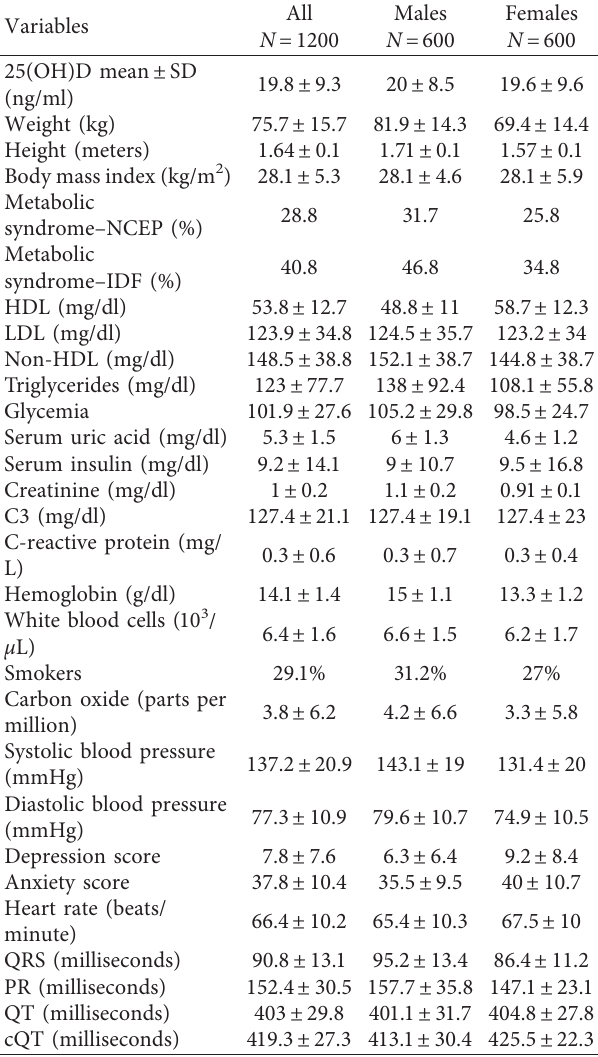
Table 1: Baseline characteristics of study participants: 600 males and 600 females (aged 25–74